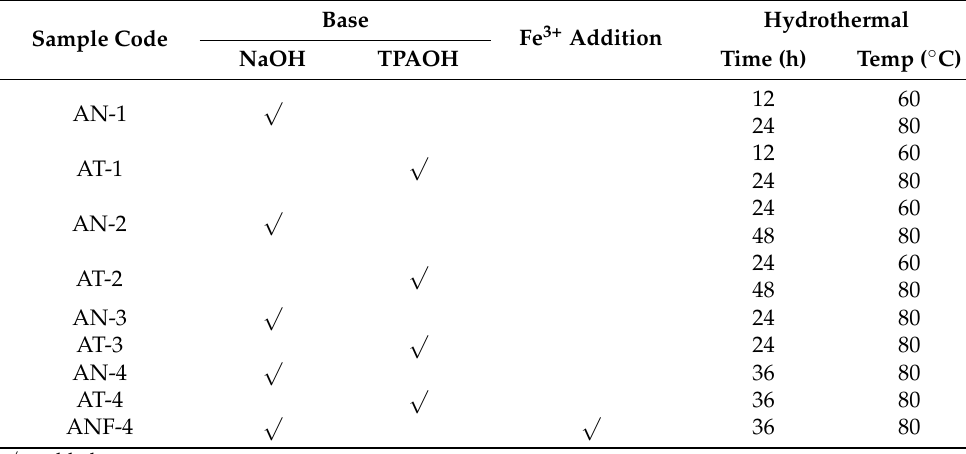
Table 3. Sample annotation and the variation of synthesis’s parameter.